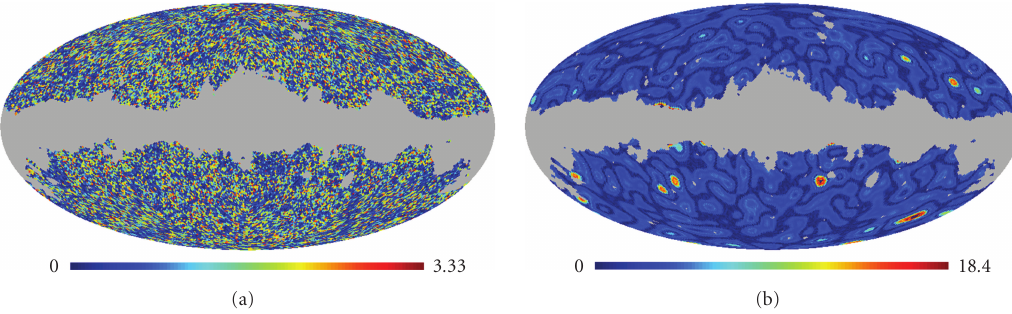
Figure 6: Maps of HC i obtained from the analysis of the QVW map derived from the WMAP data. Left panel corresponds to the study N pix of the real space case, while right panel shows the outcome of the analysis of the SMHW coe ffi cients at R = 300 arcmin. Whereas for the former there are not particular signatures in the map, the wavelet analysis shows some prominent features, being the Cold Spot the most pronounced one.